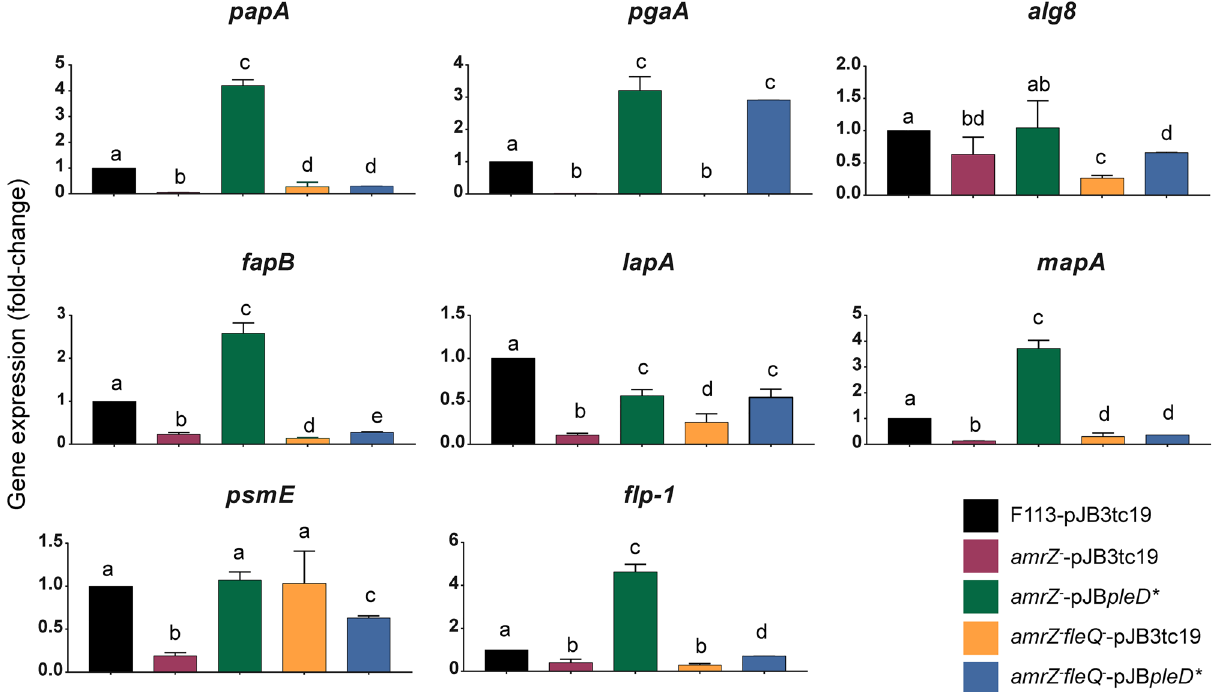
Figure 2. AmrZ regulates ECM-related genes in a c-di-GMP- and FleQ-dependent manner. qRT-PCR analysis of selected extracellular matrix-related genes in stationary phase. Gene expression from amrZ - or amrZ - fleQ - carrying pJB3Tc19 or pJB pleD* was normalized to rpoZ and relativized to the wild-type strain carrying the empty plasmid pJB3Tc19. Averages and standard deviation (SD) from two biological replicates with